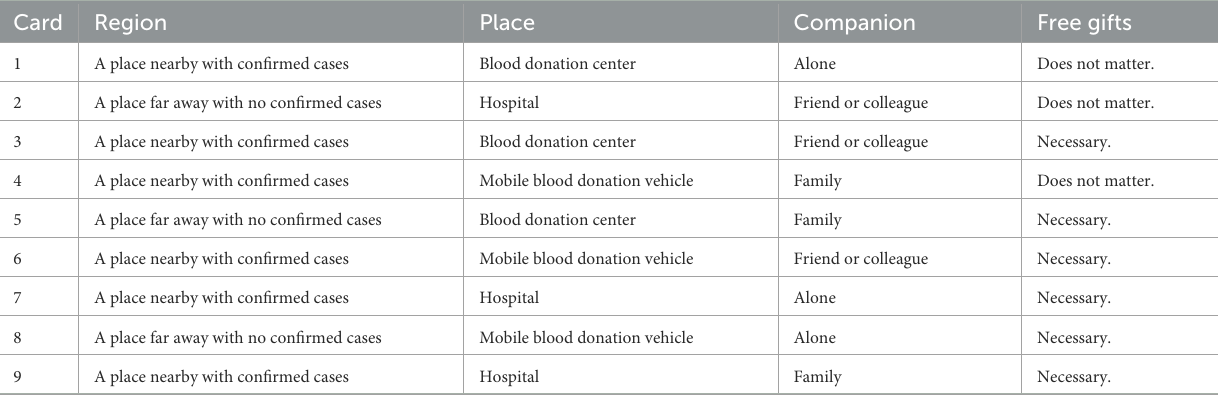
TABLE 5 Blood donation environment factor design.